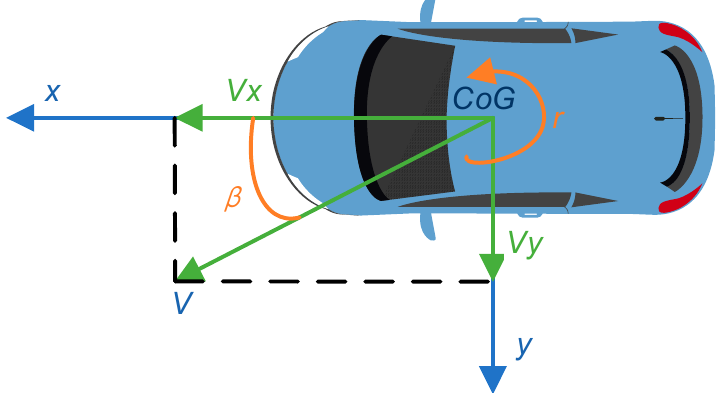
Figure 1. Top view of a vehicle with horizontal body fixed coordinate system.